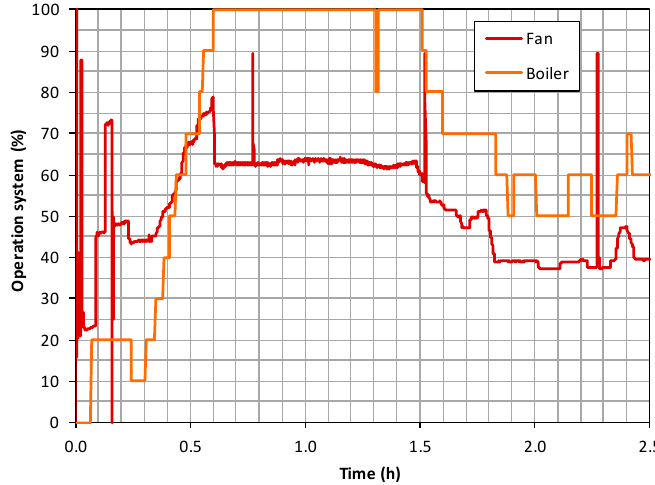
Figure 6. Boiler modulation during combustion test of pellets LAB1.